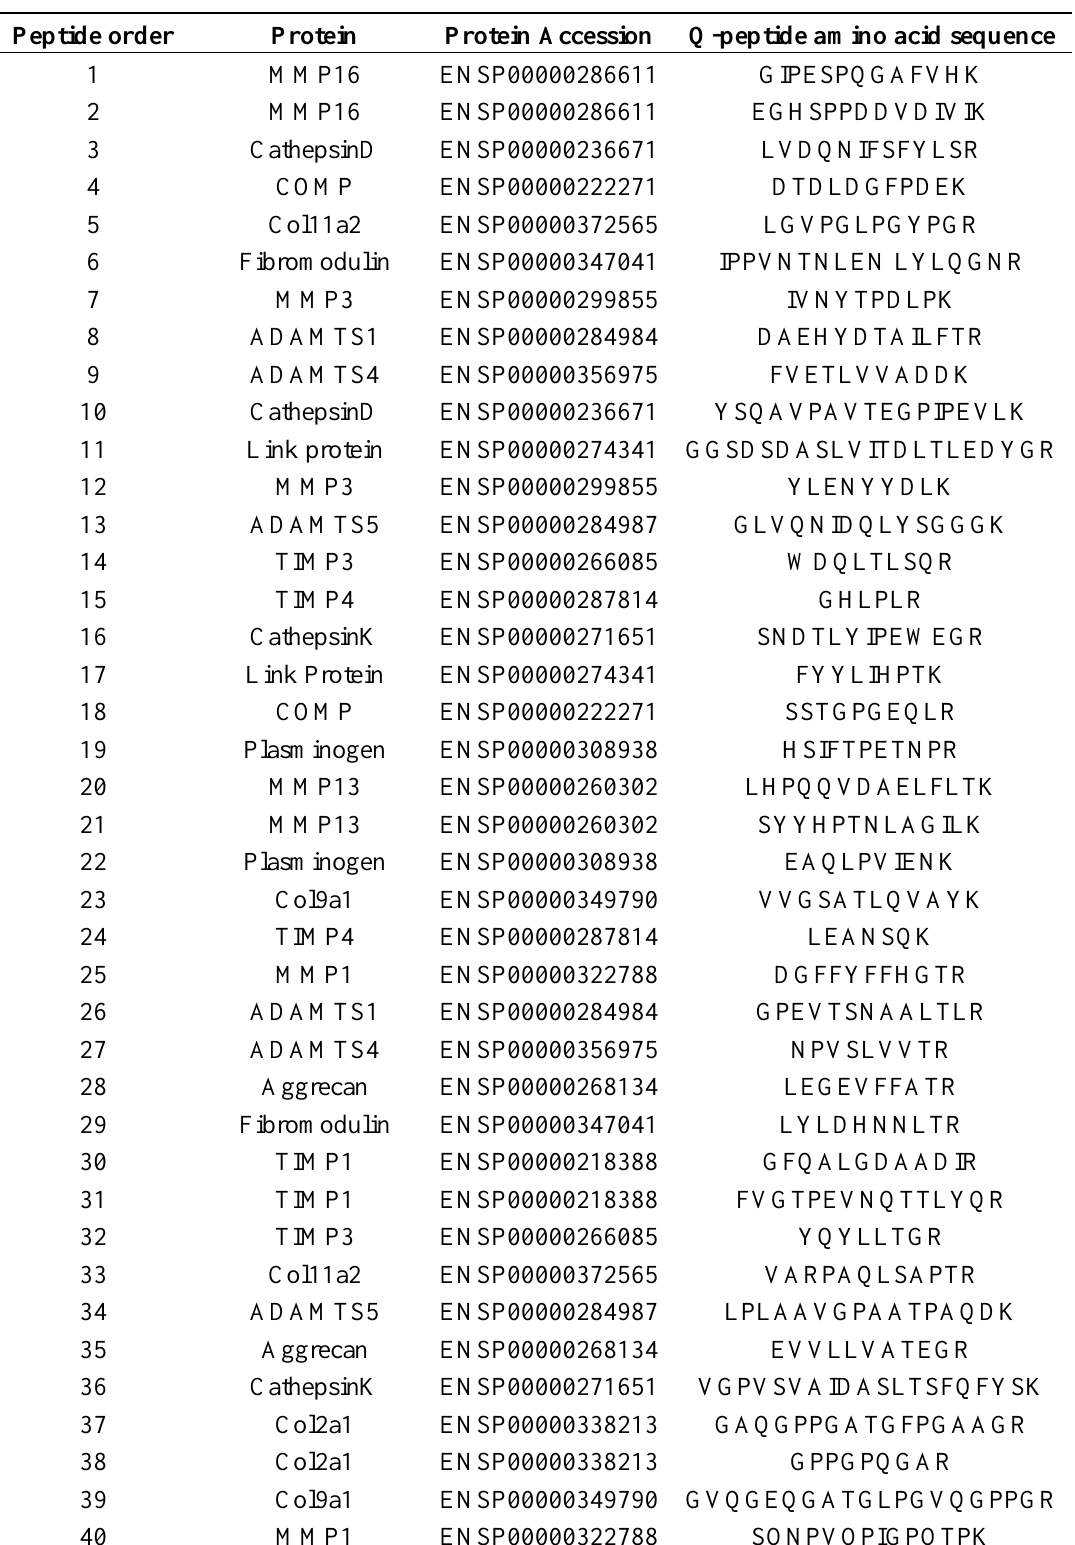
Table 3. Human cartilage QconCAT signature peptides in QconCat context order. The three amino acids found adjacent to the N and C termini of the Q-peptide within the native protein are indicated (Matrix metalloproteinase (MMP), collagen (Col), a disintegrin and metalloproteinase with thrombospondin motifs (ADAMTS), tissue inhibitor of metalloproteinase